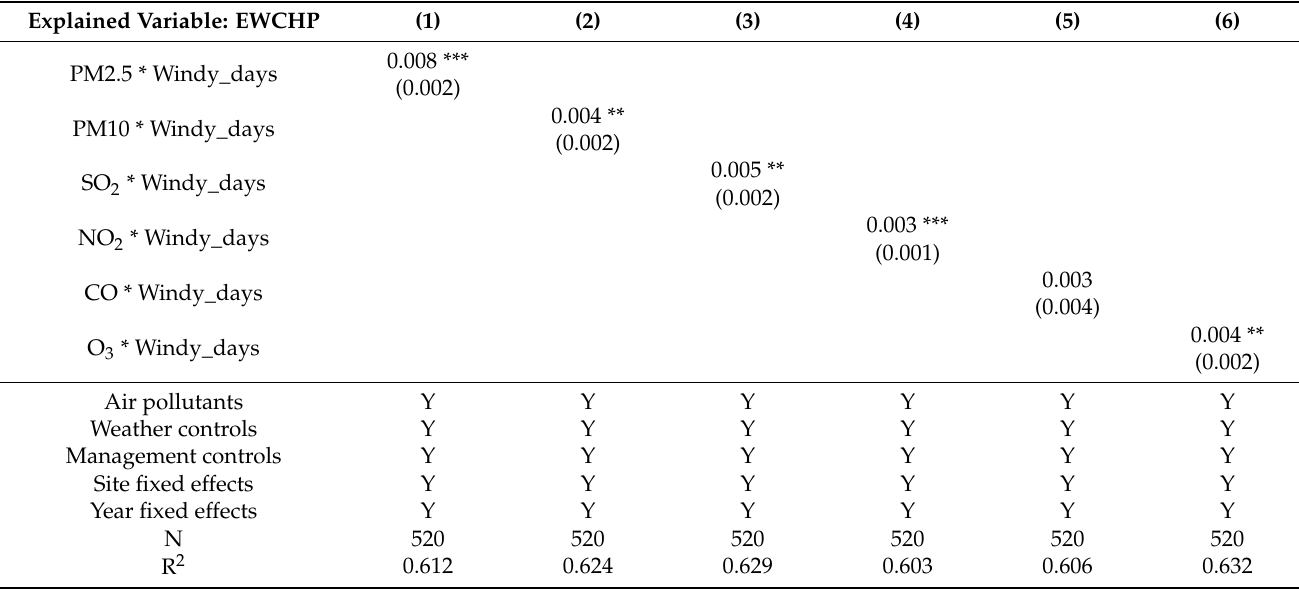
Table 7. The moderate effects of wind.